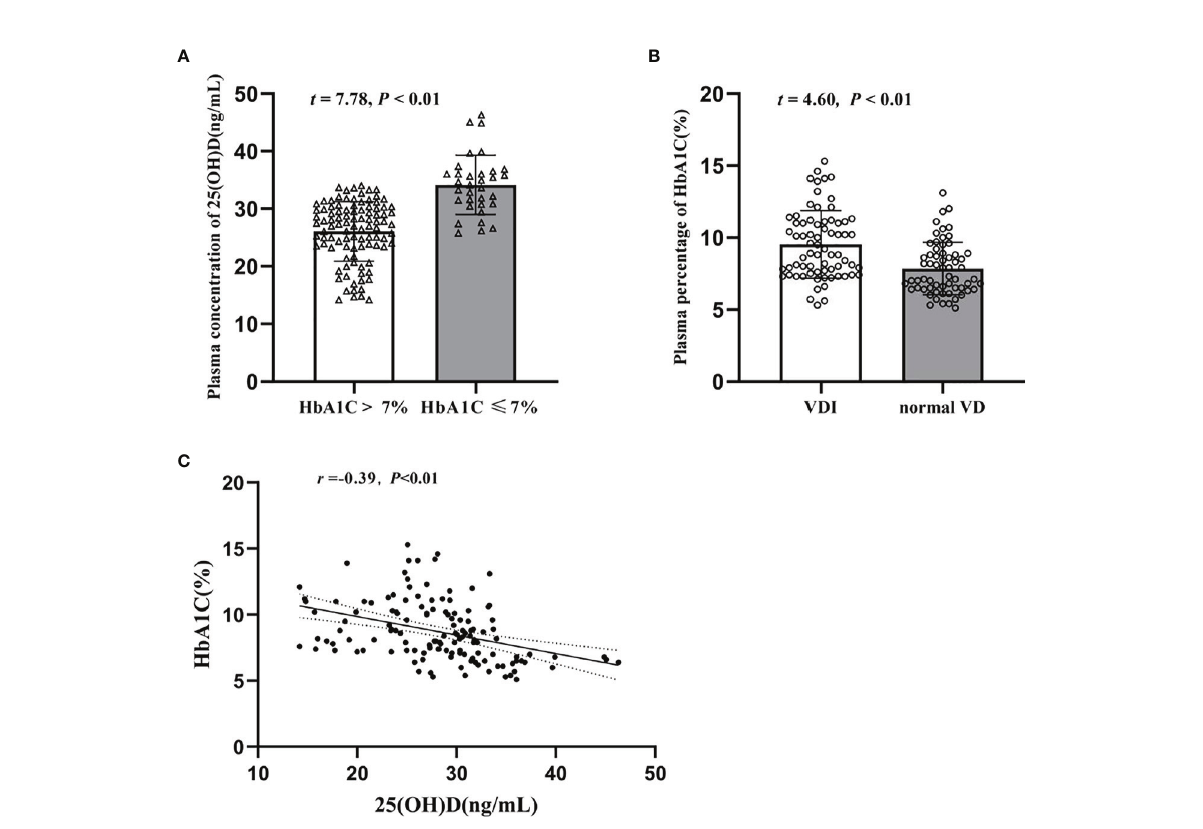
FIGURE 1 Turmoil changes of plasma levels of HbA1c and 25(OH)D in T2DM patients and their close correlation. (A) Plasma concentration of 25(OH)D (ng/mL) in HbA1c>7% and HbA1c ≤ 7%; (B) Plasma percentage of HbA1c (%) in VDI group and normal VD group; (C) Correlation between plasma 25(OH)D and plasma HbA1c